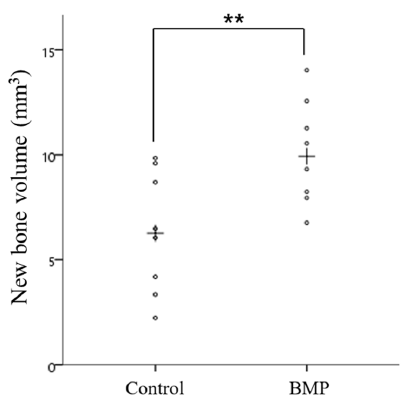
Figure 7. Scatter plot and median (the cross) representing new bone volume (mm 3 ) (** p < 0.01). The mean ( ± SD) new bone volume (mm 3 ) in the control group and BMP group was 6.30 ( ± 2.90) and 10.08 ( ± 2.48), respectively. The new bone volume (mm 3 ) was significantly higher in the BMP group than in the control group ( p <